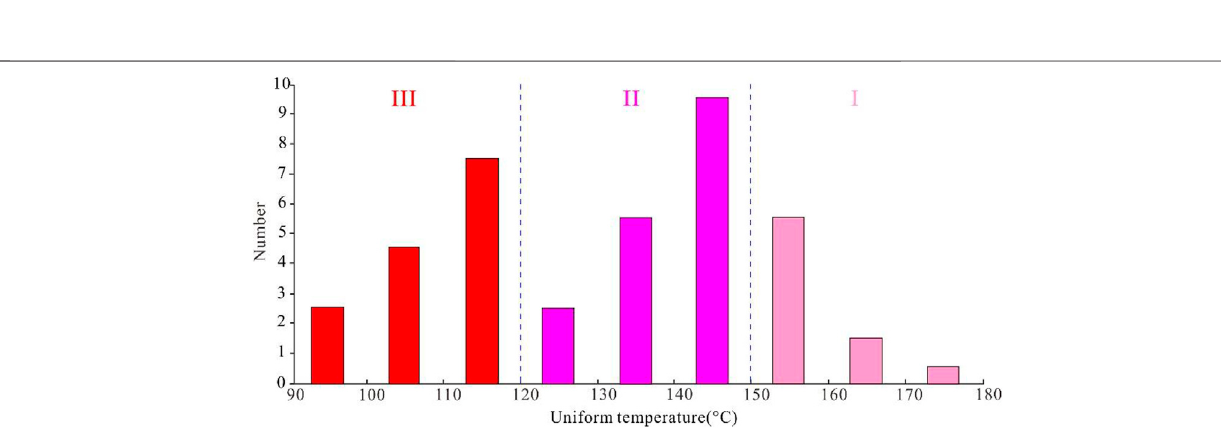
Frontiers in Earth Science |